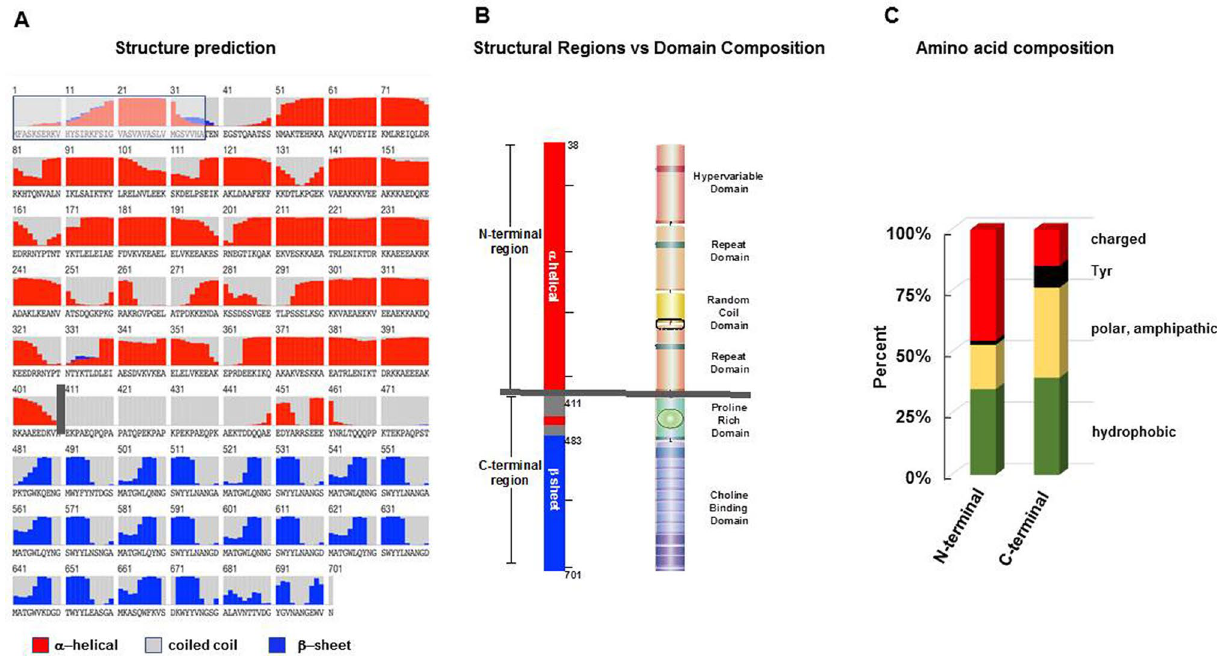
Figure 2. Structural regions and domain position of PspC3.1. Dissection of PspC3.1 into distinct structural regions using in silico analyses. ( A ) Secondary structure of the well-characterized PspC3.1 variant (strain D39). The N-terminal part of the molecule shows a long stretch composed mainly of α-helices (red bars) (aa 1–410) followed by a 72 aa coiled-coil segment (grey area) and a 219 aa region consisting mainly of β-sheet folds (blue bars). The numbers represent the amino acid position. The signal peptide (positions 1–37) which is cleaved upon processing is shown by the box with grey background and blue lines. The vertical grey bar separating the N-terminal α-helical from the coiled-coil region may represent the boundary to the bacterial cell wall. ( B ) Structural regions and domain composition of PspC3.1. The mainly α-helical region (positions 38 to 410) is termed the N-terminal region. The remainder of the protein includes the 72 aa coiled-coil and the 219 aa mainly β-sheet segments is termed the C-terminal region (left panel). To correlate structural regions with the domain composition, the known domains of PspC3.1 were included (right panel). The Hypervariable Domain, Repeat Domain I, Random Coil Domain and Repeat Domain II aligned with the N-terminal, mainly α-helical region. In the C-terminal region of the protein the coiled-coil segment consisted of the Proline-Rich Domain and the β-sheet segment with the Choline-Binding Domain. The grey horizontal line separates the N and C-terminal regions and likely marks the border of the cell wall and capsule facing the outside environment. ( C ) Amino acid composition of N and C-terminal regions. The amino acid composition was evaluated separately for each region. The N-terminal region is rich in charged residues (48%), has a low number of both polar and amphipathic residues (24%), and Tyr residues (left panel). In contrast, the C-terminal region contained a lower percentage of charged residues (22%), had more polar and amphipathic amino acids (38%) and more Tyr residues